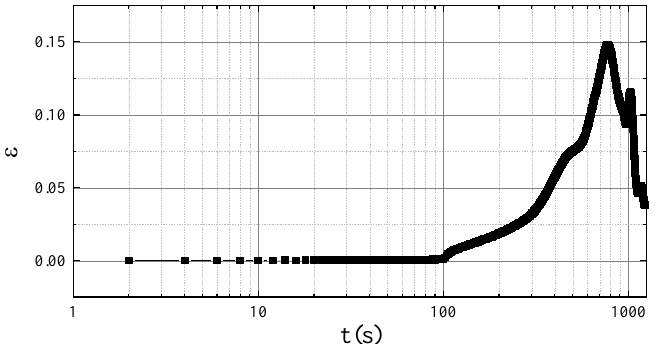
Figure 4. Time variation in the deviation difference between the k - ω model and the analytical laminar solution results.